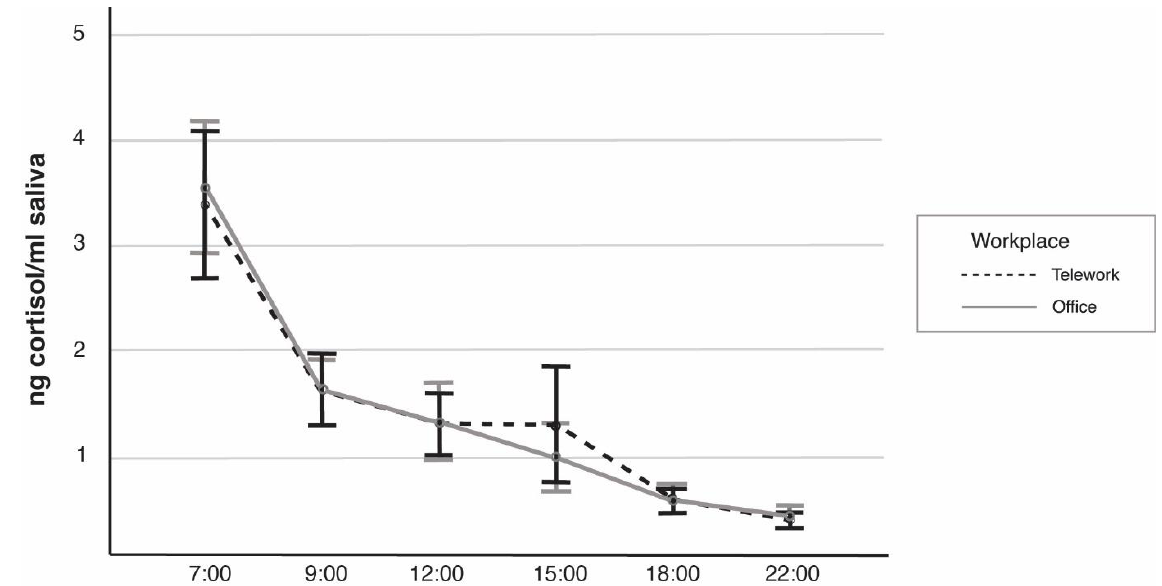
Figure 1. Estimated marginal means of Workplace (telework; office) and Time (hours of the day) from the repeated measures analysis of variance of ng cortisol/mL saliva ( n = 23). Error bars represent 95% confidence interval.